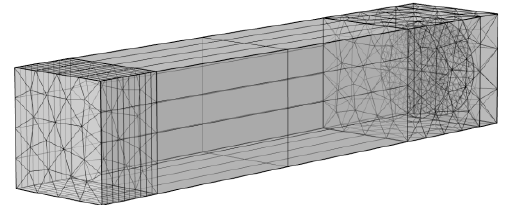
Figure 4. Mesh model.